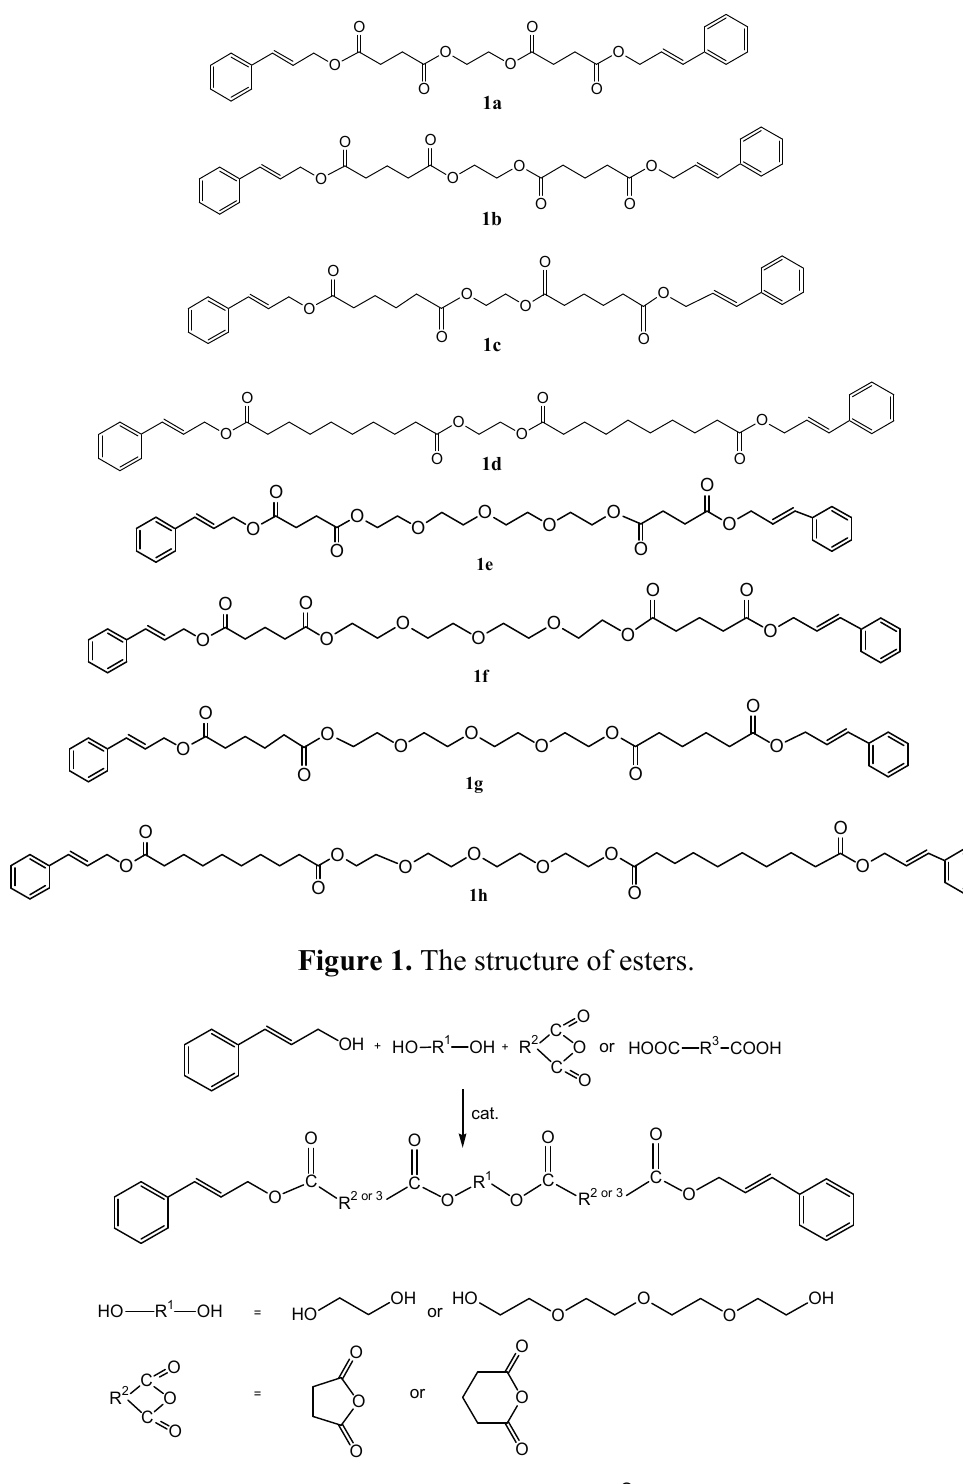
Scheme 1. The reaction